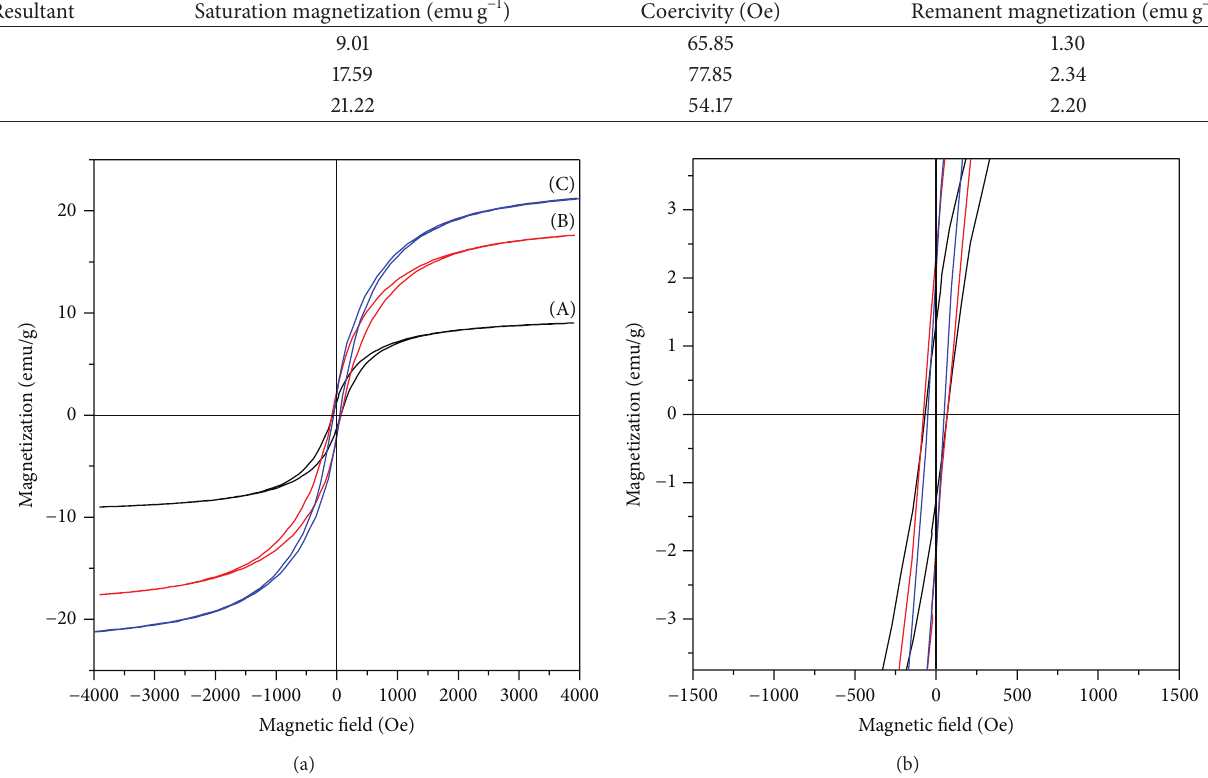
Table 2: The saturation magnetization, coercivity, and remanent magnetization of the resultants. Resultant